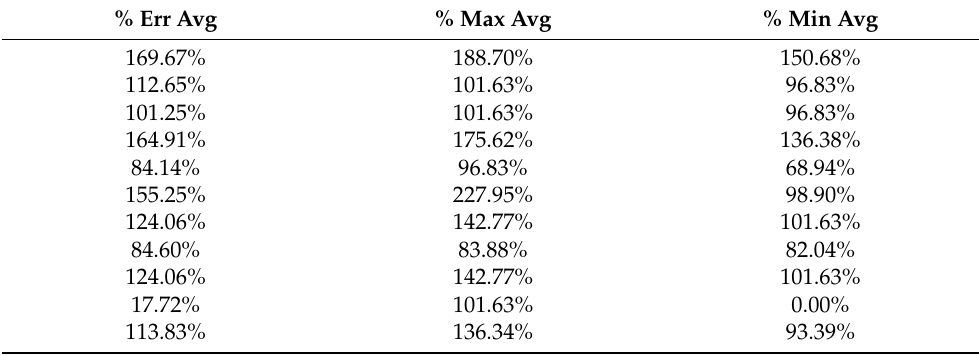
Table A196. Set 3, trials 21–30 data (all 0.5 PR